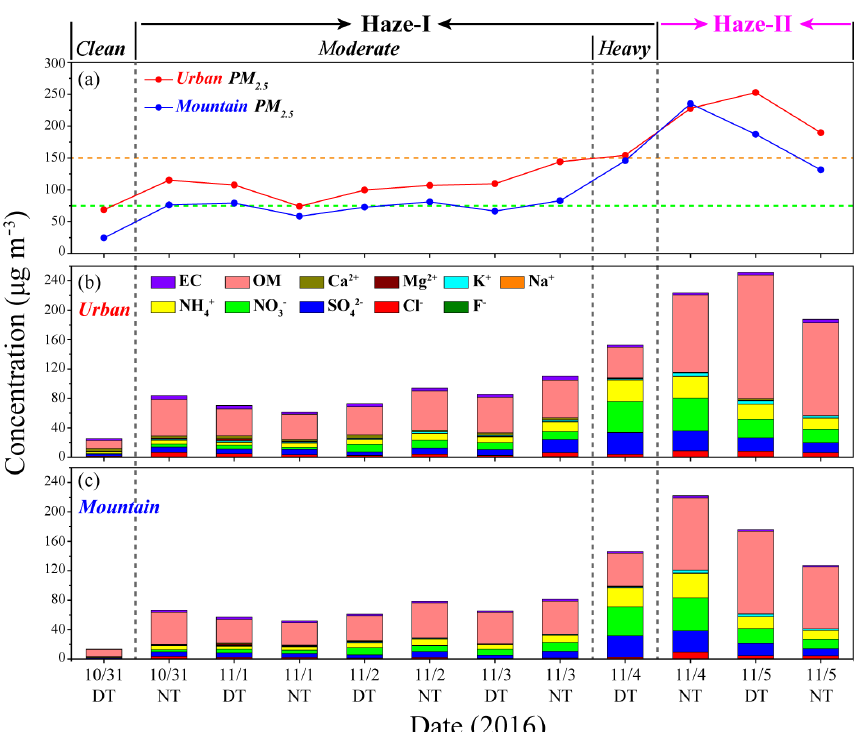
Figure 2. Variation in the concentrations of PM 2 . 5 , organic matter (OM), elemental carbon (EC), and water-soluble ions (i.e., , NO − , SO 2 − , Cl − , and F − ) at the urban and mountain sites from daytime (DT) on 31 October to nighttime Ca 2 + , Mg 2 + , K + , Na + , NH + 4 3 4 (NT) on 5 November 2016: (a) PM 2 . 5 ; (b, c) OM, EC, and water-soluble ions. Two regional haze episodes (Haze-I: 31 NT October–4 DT November; Haze-II: 4 NT–5 NT November) were